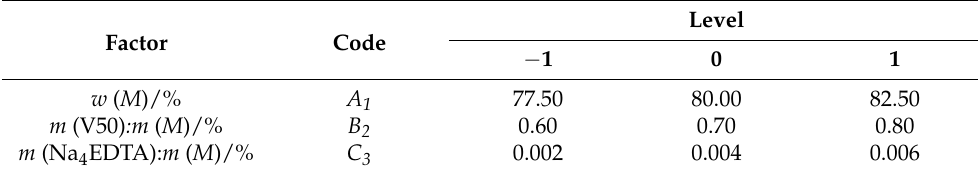
Table 1. Feed ratio factor coding and level.